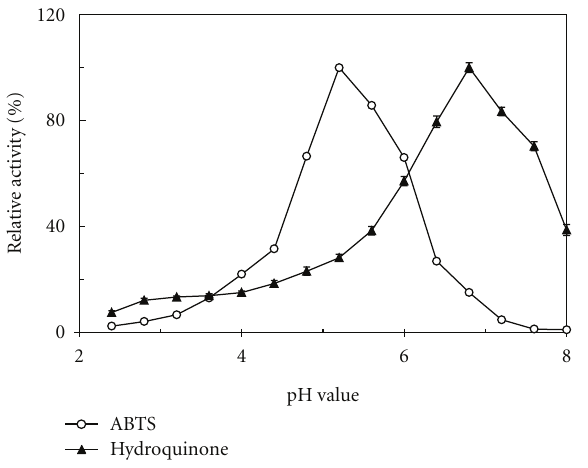
Figure 4: pH optimum of A. placomyces laccase.